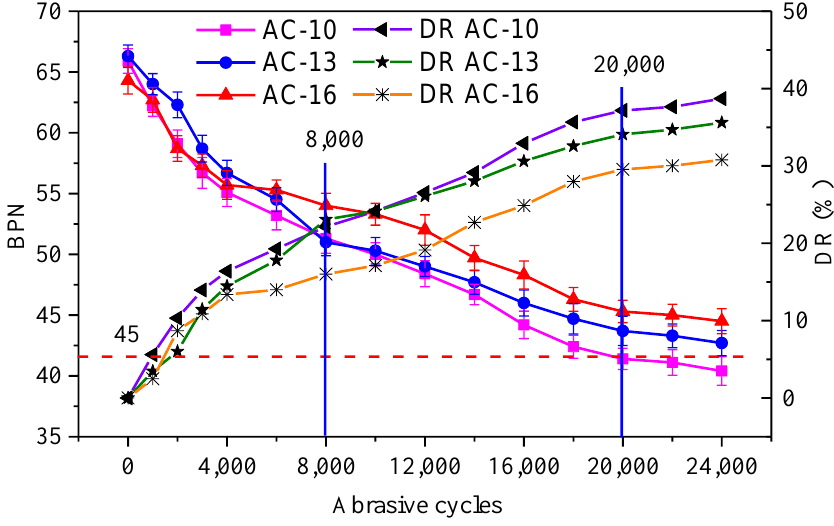
Figure 6. BPN and DR of asphalt pavement with various NMAS.